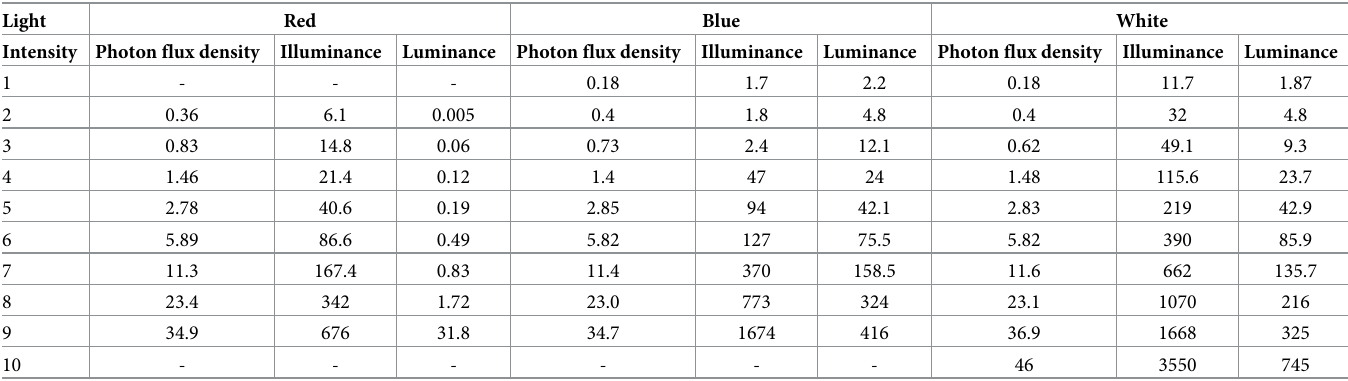
Table 1. Light intensity levels used in the experiments, expressed as photon flux density ( μ mol s -1 m -2 ), illuminance (lux), and luminance (candela/m 2 ). Light Red